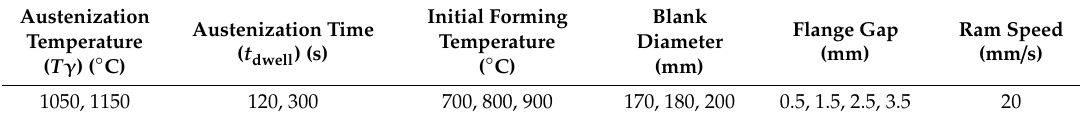
Table 4. Summarize of the thermomechanical process parameters used for the deep drawing tests.